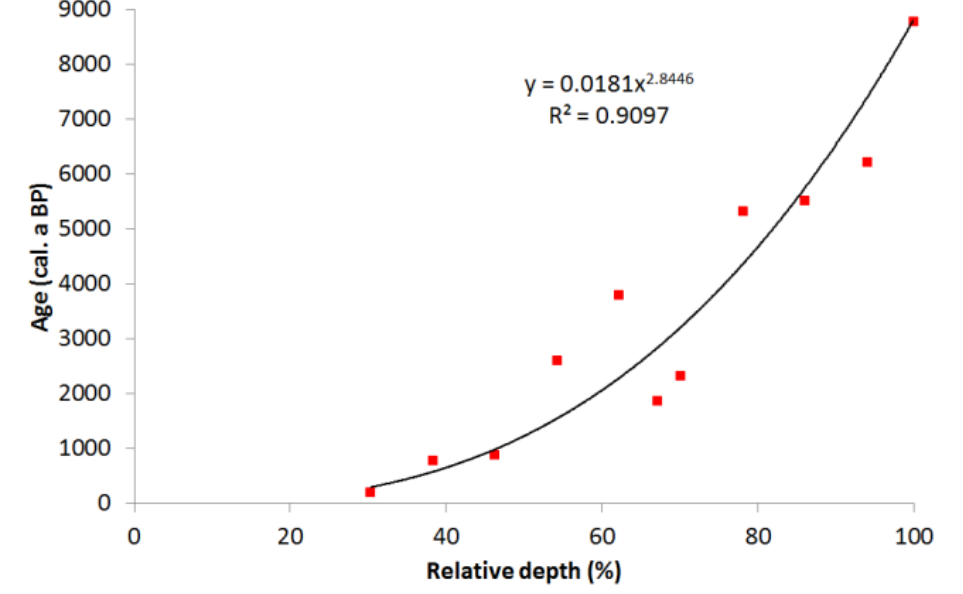
Figure 2. Age-depth model based on 14 C dates from Fyfe et al . (2008), showing calibrated 14 C age as a function of relative depth.